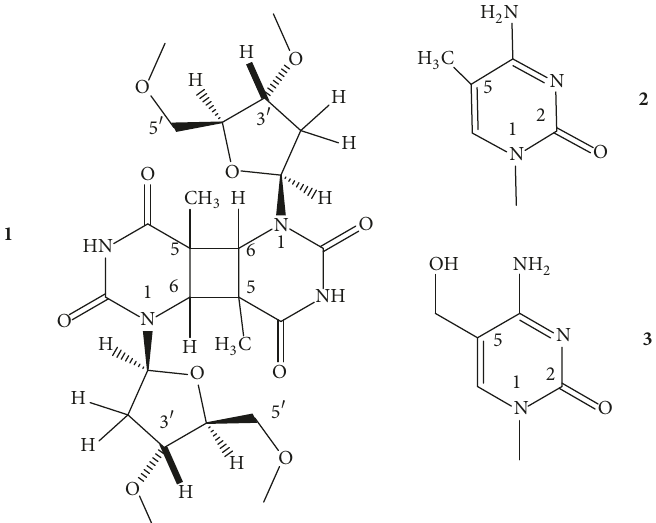
Figure 16: Structure of the anti cyclobutane thymine dimer ( 1 ), 5-methylcytosine ( 2 ), and the 5-hydroxymethylcytosine ( 3 ).